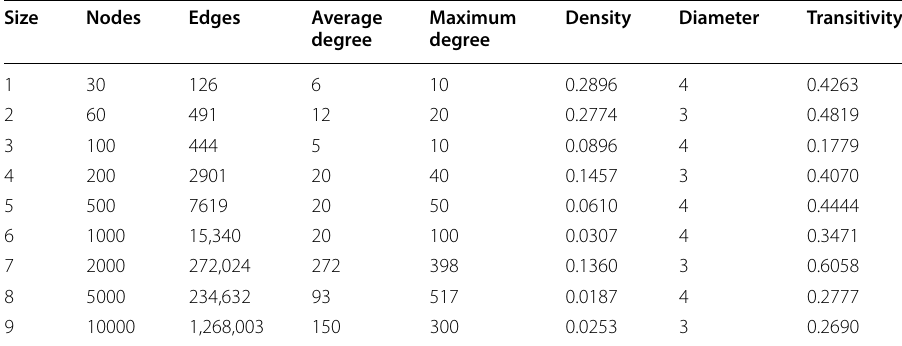
Table 4 Unweighted artificial networks generated from the LFR benchmark. The mixing parameter